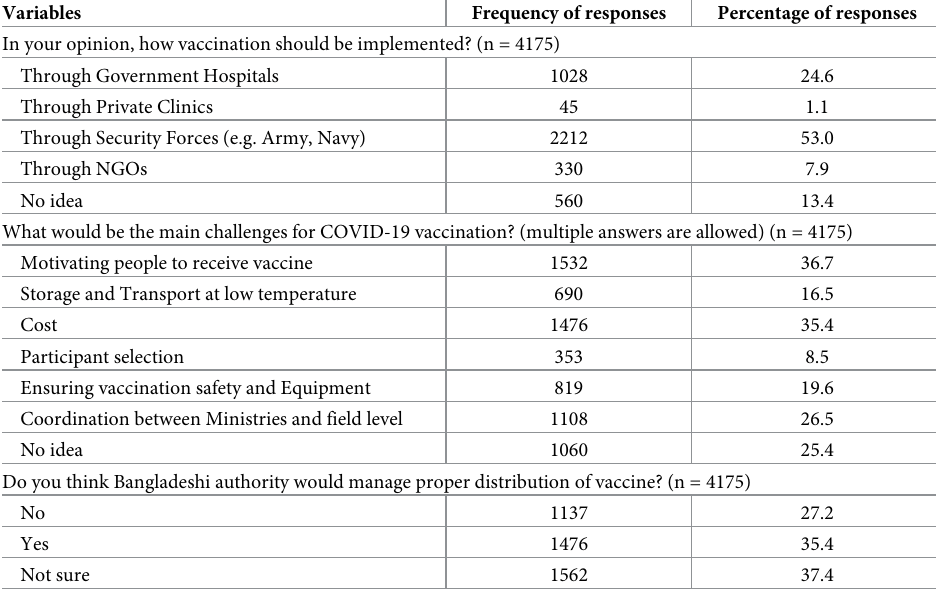
Table 6. Respondents’ opinion on management of COVID-19